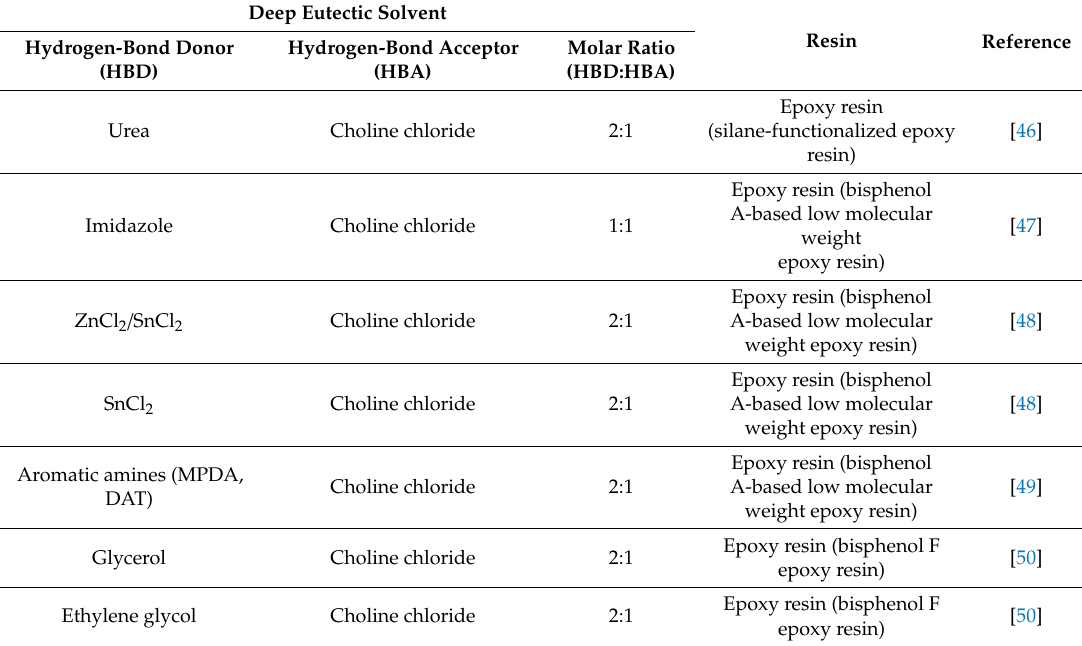
Table 1. Summary of applications of deep eutectic solvents (DESs) in composite resin